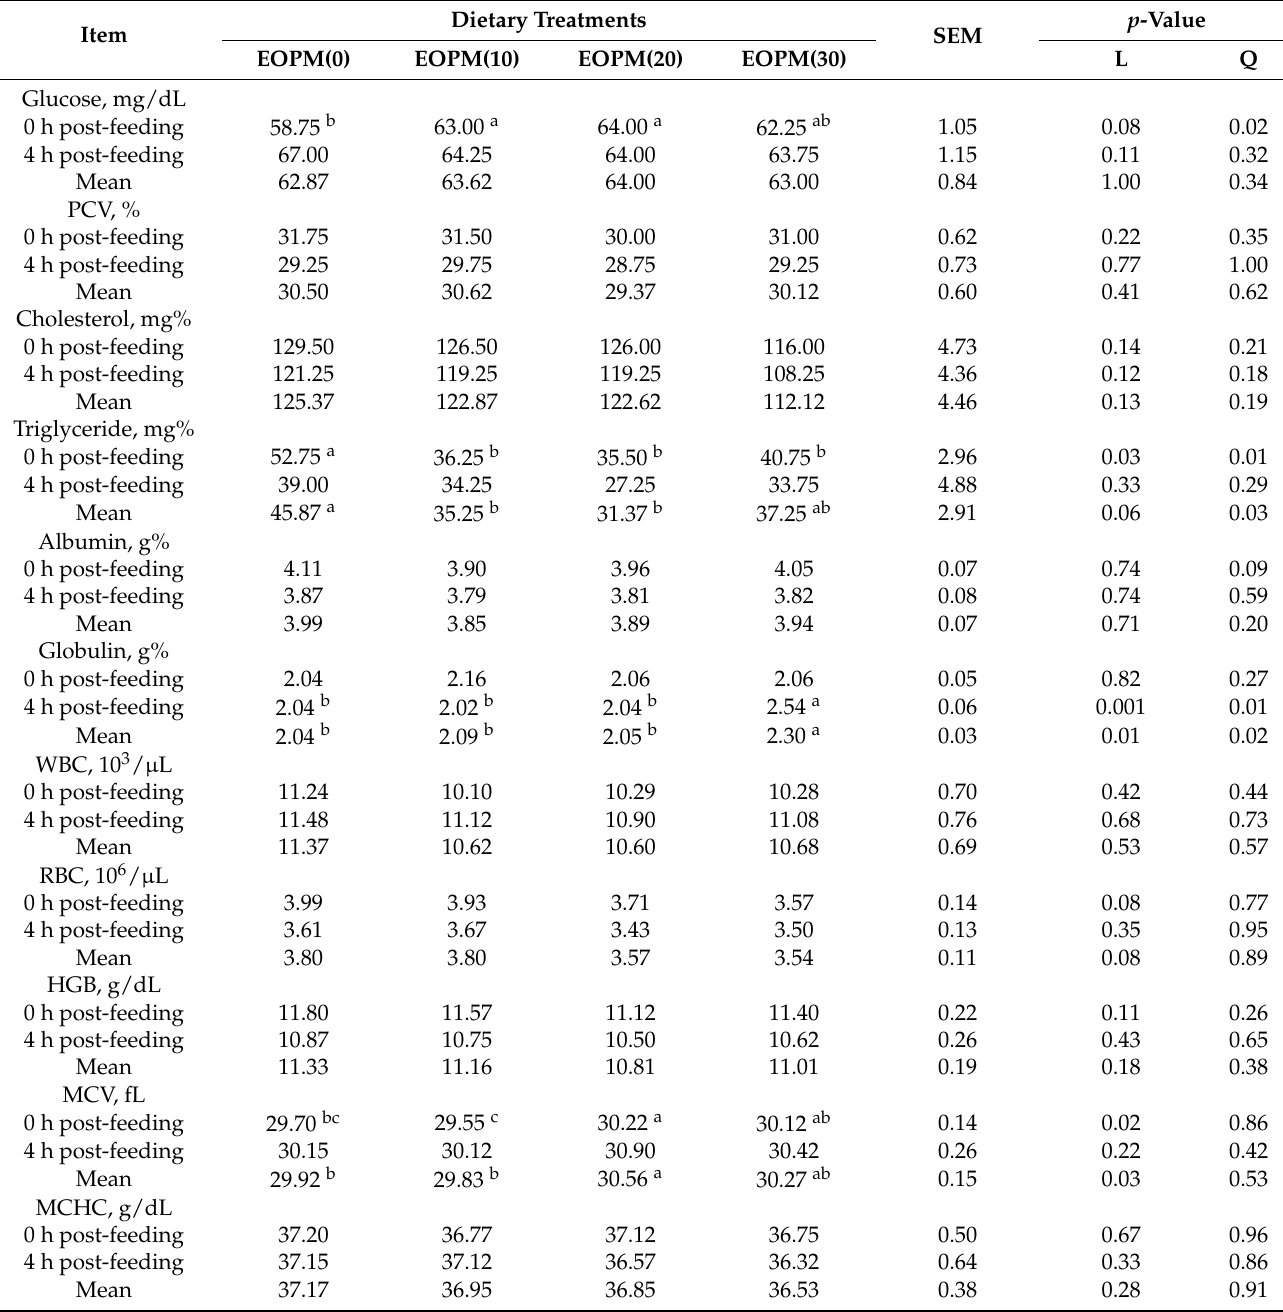
Table 5. Blood metabolites in goats fed TMR diets containing extracted oil palm meal